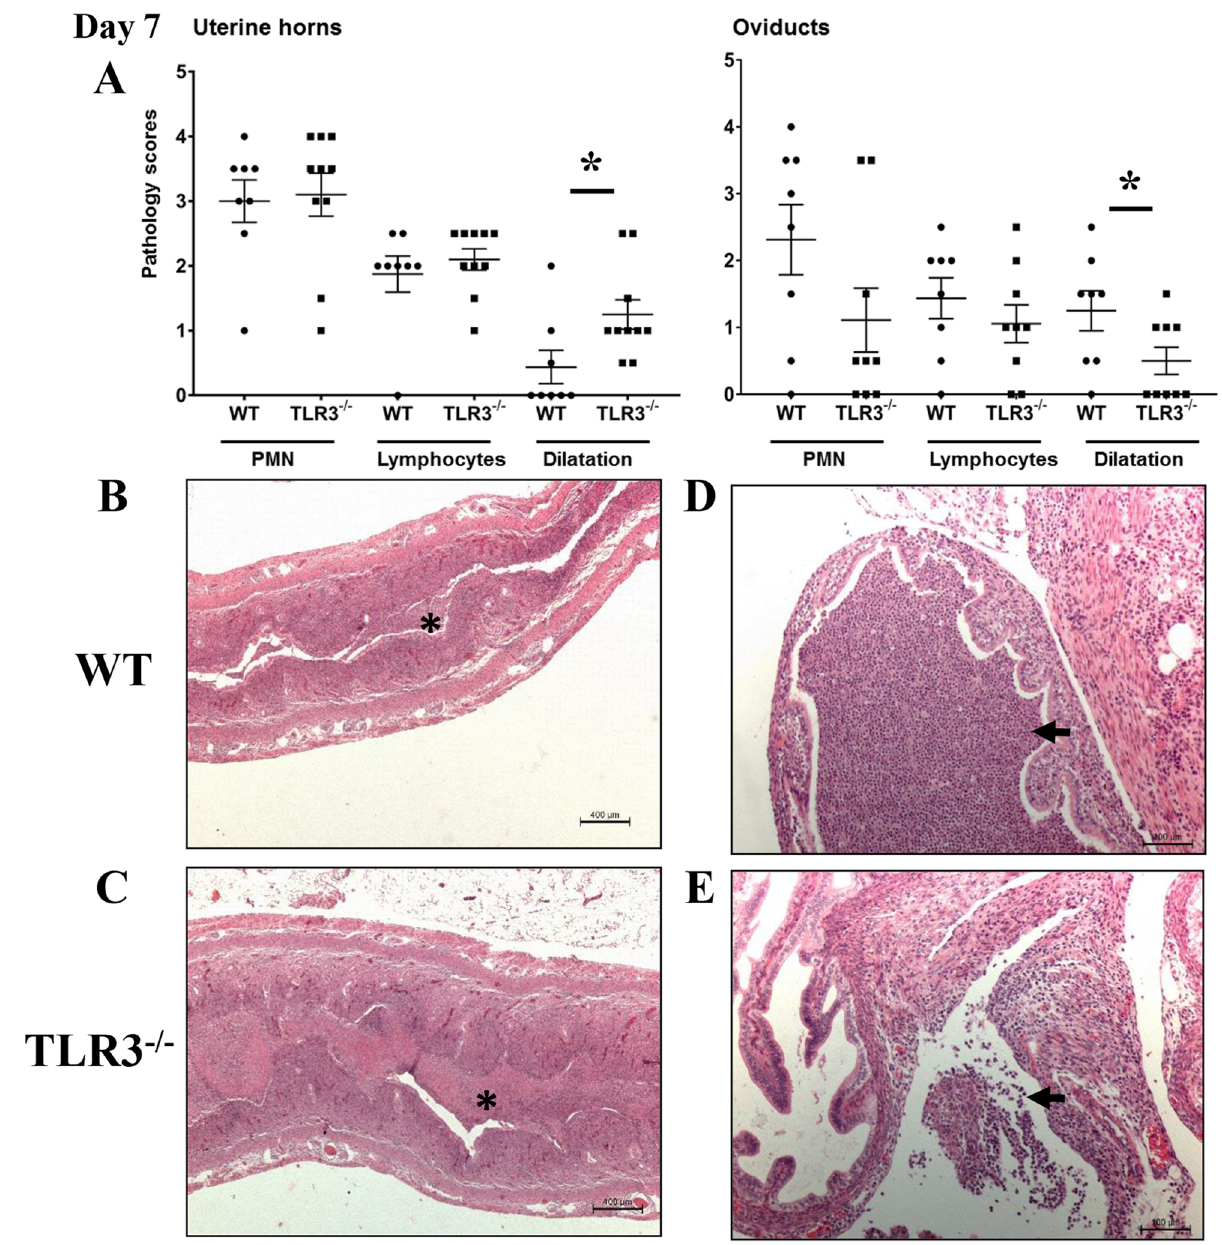
Fig 2. Acute inflammation in uterine horns and oviducts of wild-type (WT) and TLR3 deficient (TLR3 -/- ) mice on day 7 of Chlamydia infection. A) The extent of histopathological changes of both uterine horns and oviducts were scored using a four-tiered semi-quantitative scoring system in a double-blind fashion. These results were representative of 8–10 mice per group from three independent experiments. Differences between groups for each parameter were determined by two-tailed Mann-Whitney test ( (cid:3) = p < 0.05 ).Only significant results are displayed in graphs. B-C) Histopathological evaluation of uterine horns from WT and TLR3 -/- mice shows that PMNs were commonly infiltrating the lumina of the uterine horns (asterisk) in both mouse strains. Uterine horn dilatation was frequently noted in infected TLR3 -/- mice (scale bar 100μm, 25x magnification). D-E) Histopathological evaluation of oviducts from WT and TLR3 -/- mice on day 7 of infection revealed mild oviduct dilatation in WT mice, but minimal oviduct dilatation in TLR3 -/- mice (scale bar 400μm, 100x magnification). There were PMN clusters in the lumina of oviducts (arrow). No significant differences of neutrophilic or lymphocytic infiltration was noted between the genital tracts of WT and TLR3 -/- mice. Representative images for WT and TLR3 -/- mice are shown . (• = WT mouse; ▪ = TLR3 -/- mouse) .